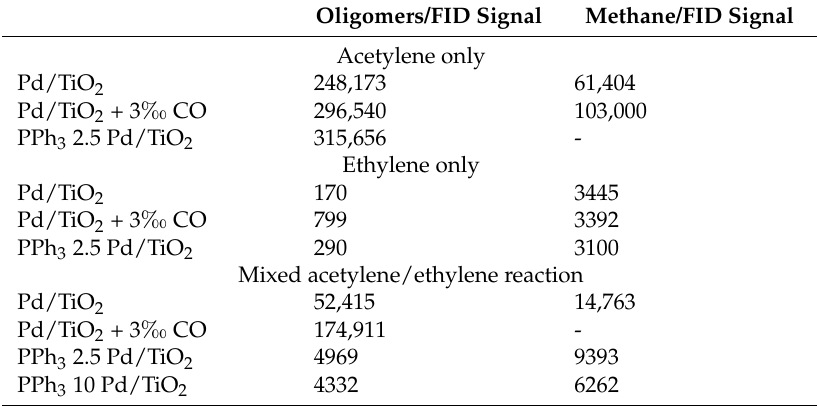
Figure 10. Hydrogenation rates of acetylene (black) and ethylene (shaded green): 1—Pd/TiO 2 , 2—Pd/TiO 2 with 3 ‰ CO in feed, 3—PPh 3 2.5 Pd/TiO 2 (reproduced with permission from [263]. Copyright 2015, the Royal Society of Chemistry). Table 1. Byproducts formed at 120 min of on-stream hydrogenation (323 K, 1 bar) for acetylene only, ethylene only, and acetylene/ethylene